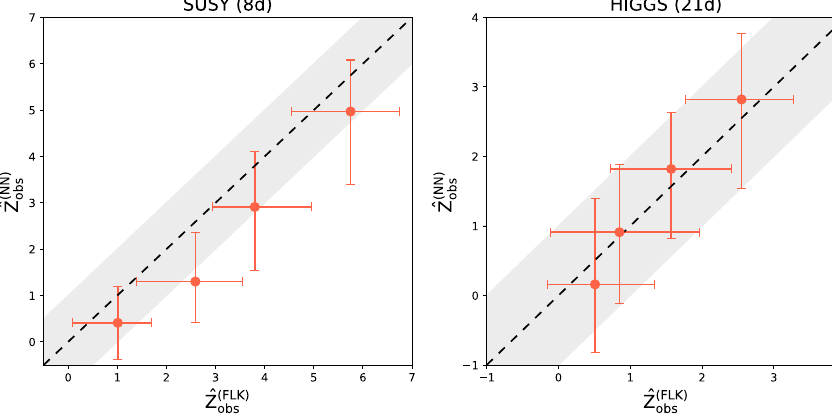
Fig. 4 Comparison of the observed significance obtained with Falkon using low level features only and all the features Fig. 5 Observed